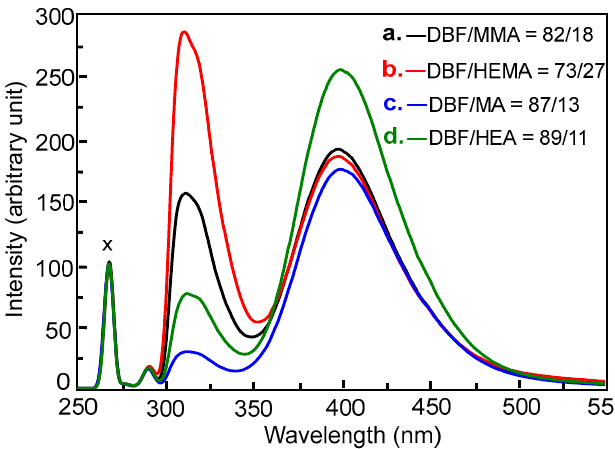
Figure 3. Fluorescent emission spectra of poly(DBF- co -MMA) ([DBF]/[MMA] in polymer = 82/18) (a), poly(DBF- co -HEMA) ([DBF]/[HEMA] in polymer = 73/27) (b), poly(DBF- co -MA) ([DBF]/[MA] in polymer = 87/13) (c), and poly(DBF- co -HEA) ([DBF]/[HEA] in polymer = 89/11) (d) [ λ ex = 267 nm, [DBF residue] = 0.94~1.15 × 10 − 5 M, THF, 1-cm cell, room temp.]. X denotes the excitation light signal.